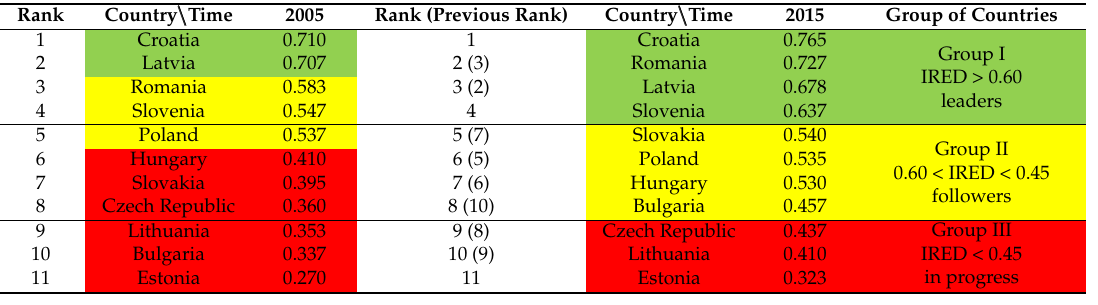
Table 6. Country ranking in 2005 and 2015 according to